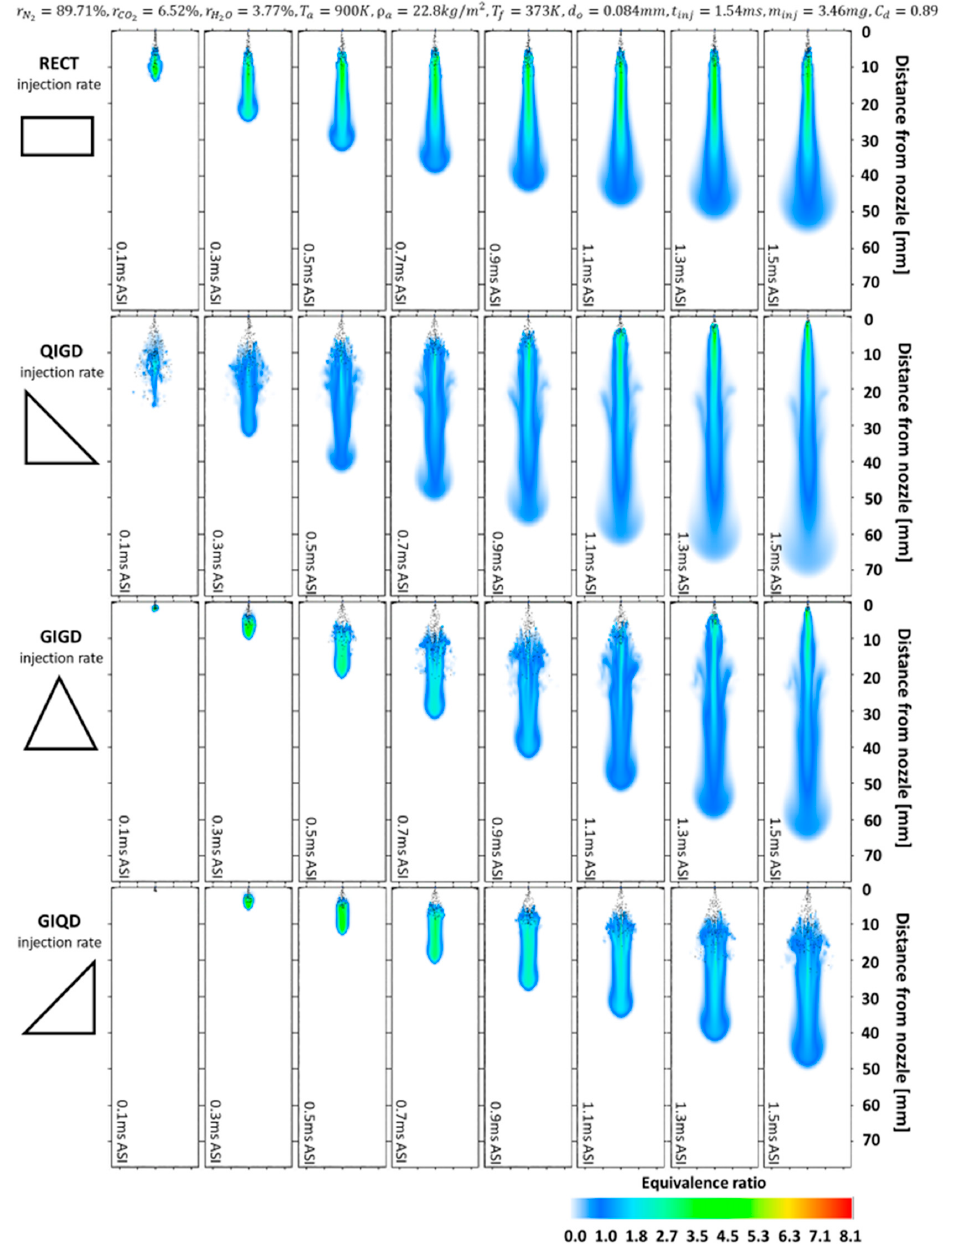
Figure 20. Comparison of the spray behavior and equivalence ratio histories during injection for different injection rate shapes.